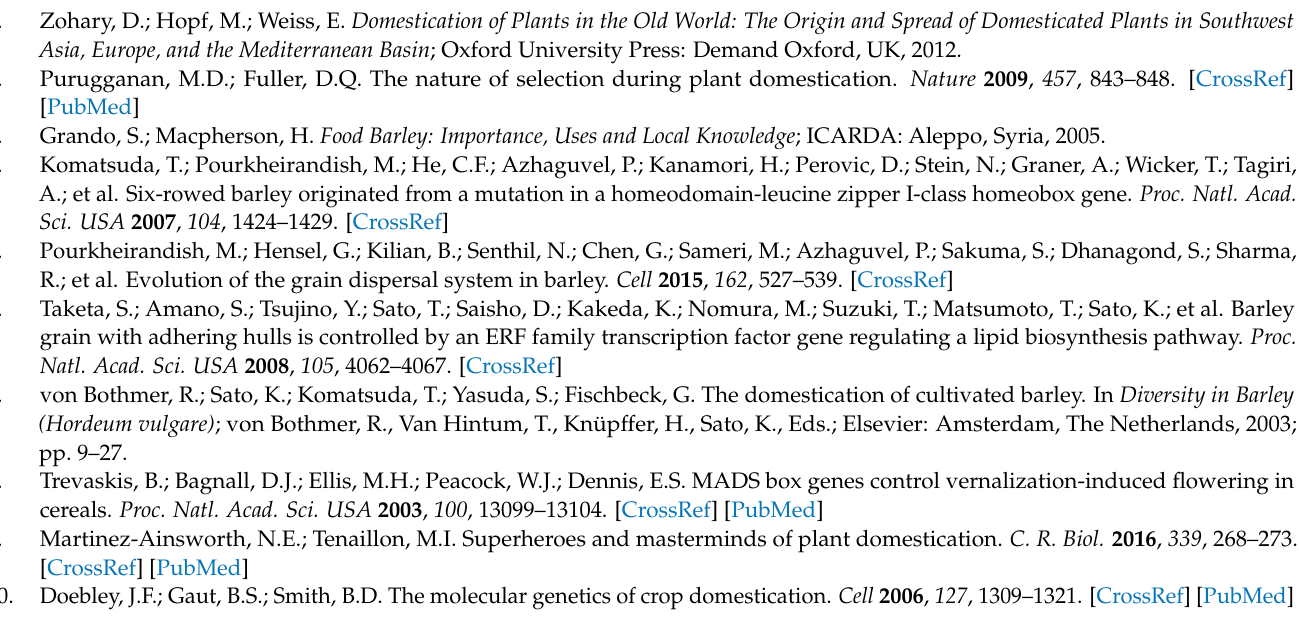
barley. Figure S2: Chromosomal locations of HvWRKYs . Figure S3: Violinplot of the Tajima’s D of all genes and WRKYs in wild and cultivated barley population. Table S1: The WRKY genes identified from cultivated barley, Table S2: The WRKY genes identified from wild barley. Table S3: Presence and position of conserved domains identified within barley WRKY proteins using HMMER. Table S4: Tandemly and segmentally duplicated genes identified in HvWRKYs . Table S5: Passport information of 227 barley accessions and the haplotypes of five HvWRKYs . Table S6: Sequence diversity and selection statistics of WRKY genes in wild and cultivated barley populations. Table S7: